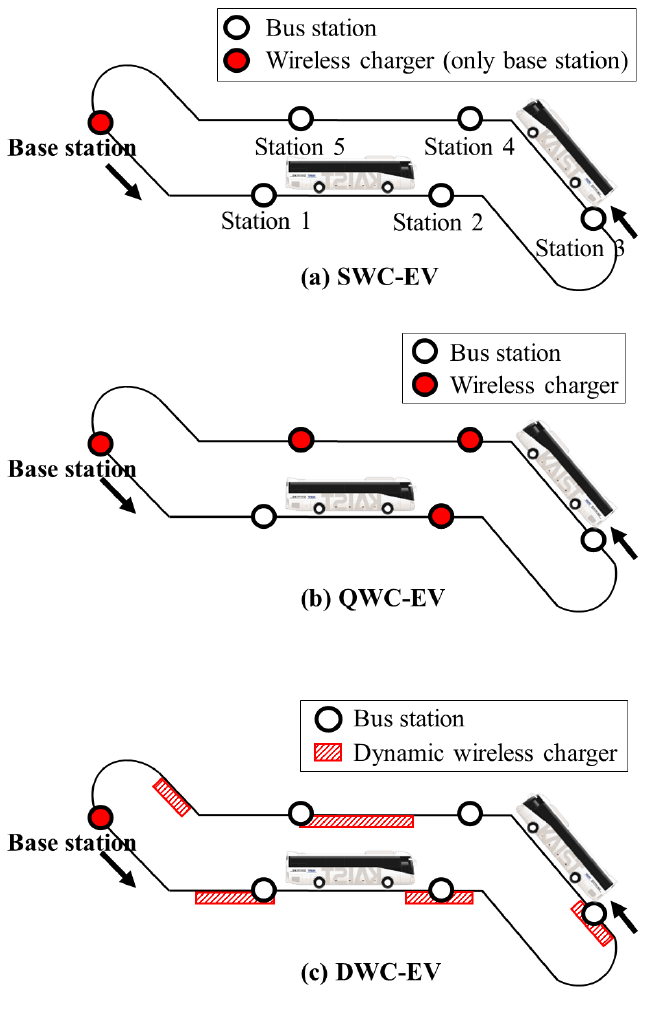
Figure 3. Charging allocation properties for each type of EV. ( a ) SWC-EV; ( d ) QWC-EV; ( c )